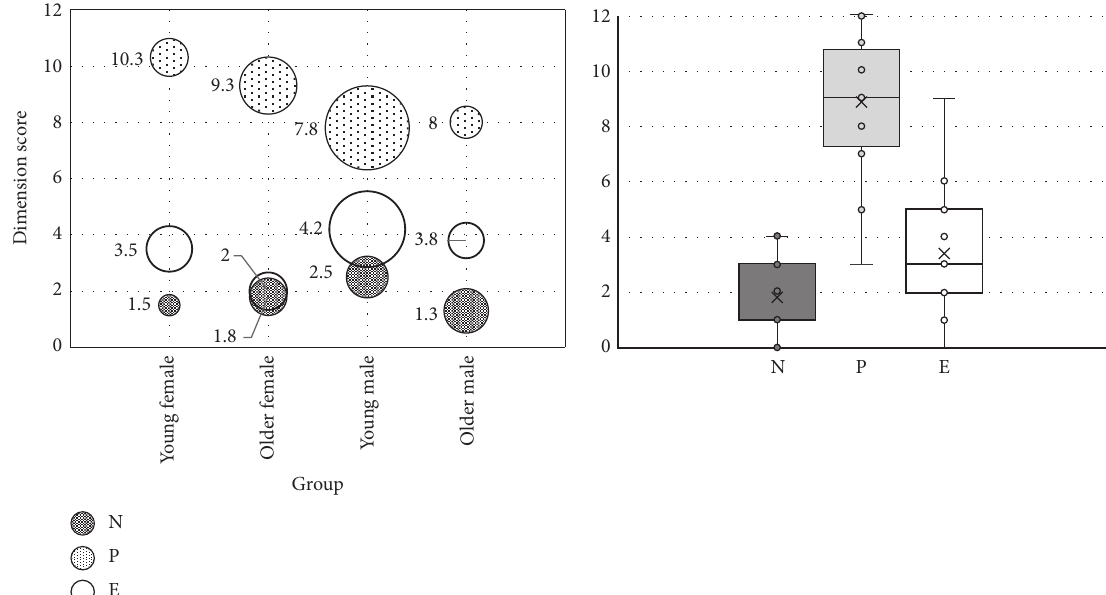
Figure 3: EPQ-RSC measures (N: neuroticism; P: psychoticism; E: extraversion; bubble width indicates one unit of standard deviation).